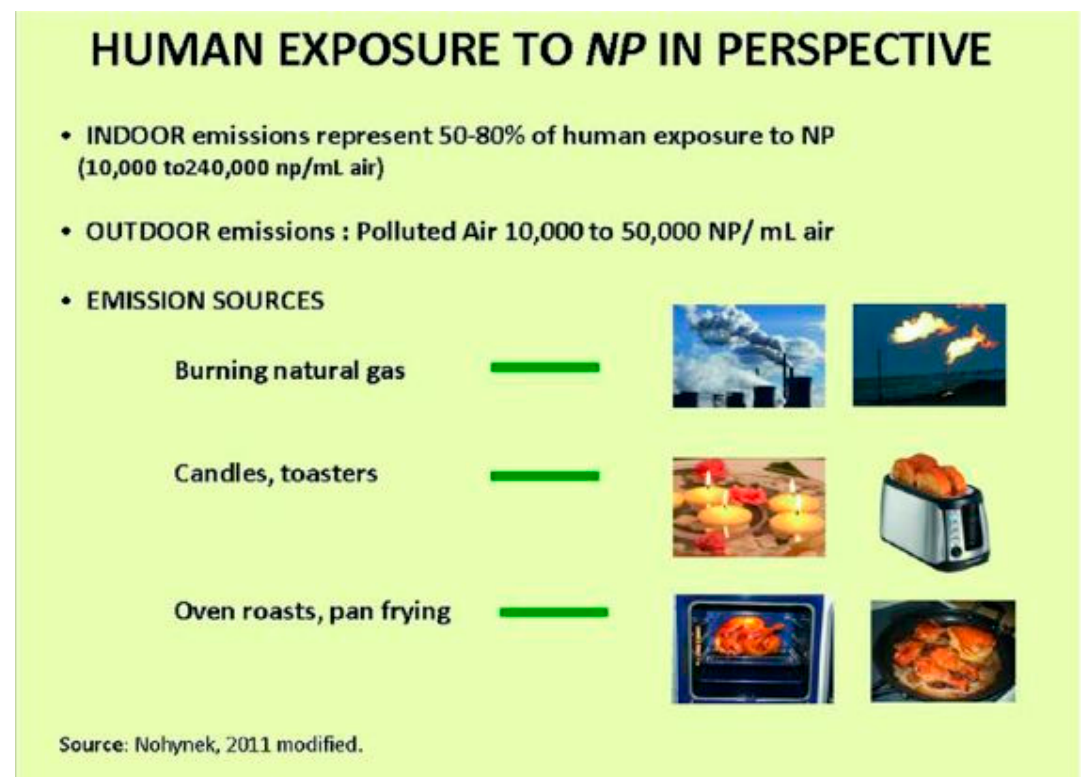
Figure 3. Indoor and outdoor particulates exposure.